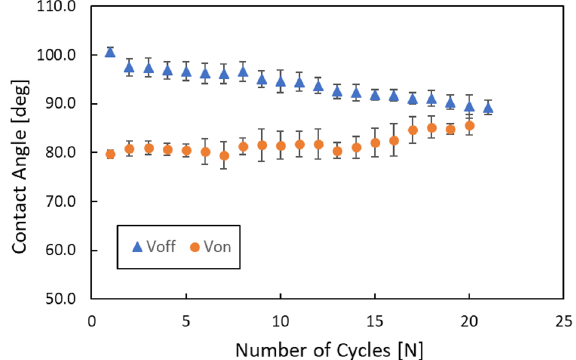
Figure 7. Repeatability of the height control of a droplet by EWOD. The wettability of the circular pattern composed of O 2 -plasma-treated parylene C and Cytop ® is estimated through repeated tests of 20 cycles. The contact angle changes after the first operation by EWOD and maintains a similar angle for a while after the first change. The change in the contact angle becomes nonnegligible between 5 and 10 cycles. When the switching of EWOD is repeated for 20 cycles, the difference between the contact angle with/without EWOD becomes too small to control the contact of the droplet